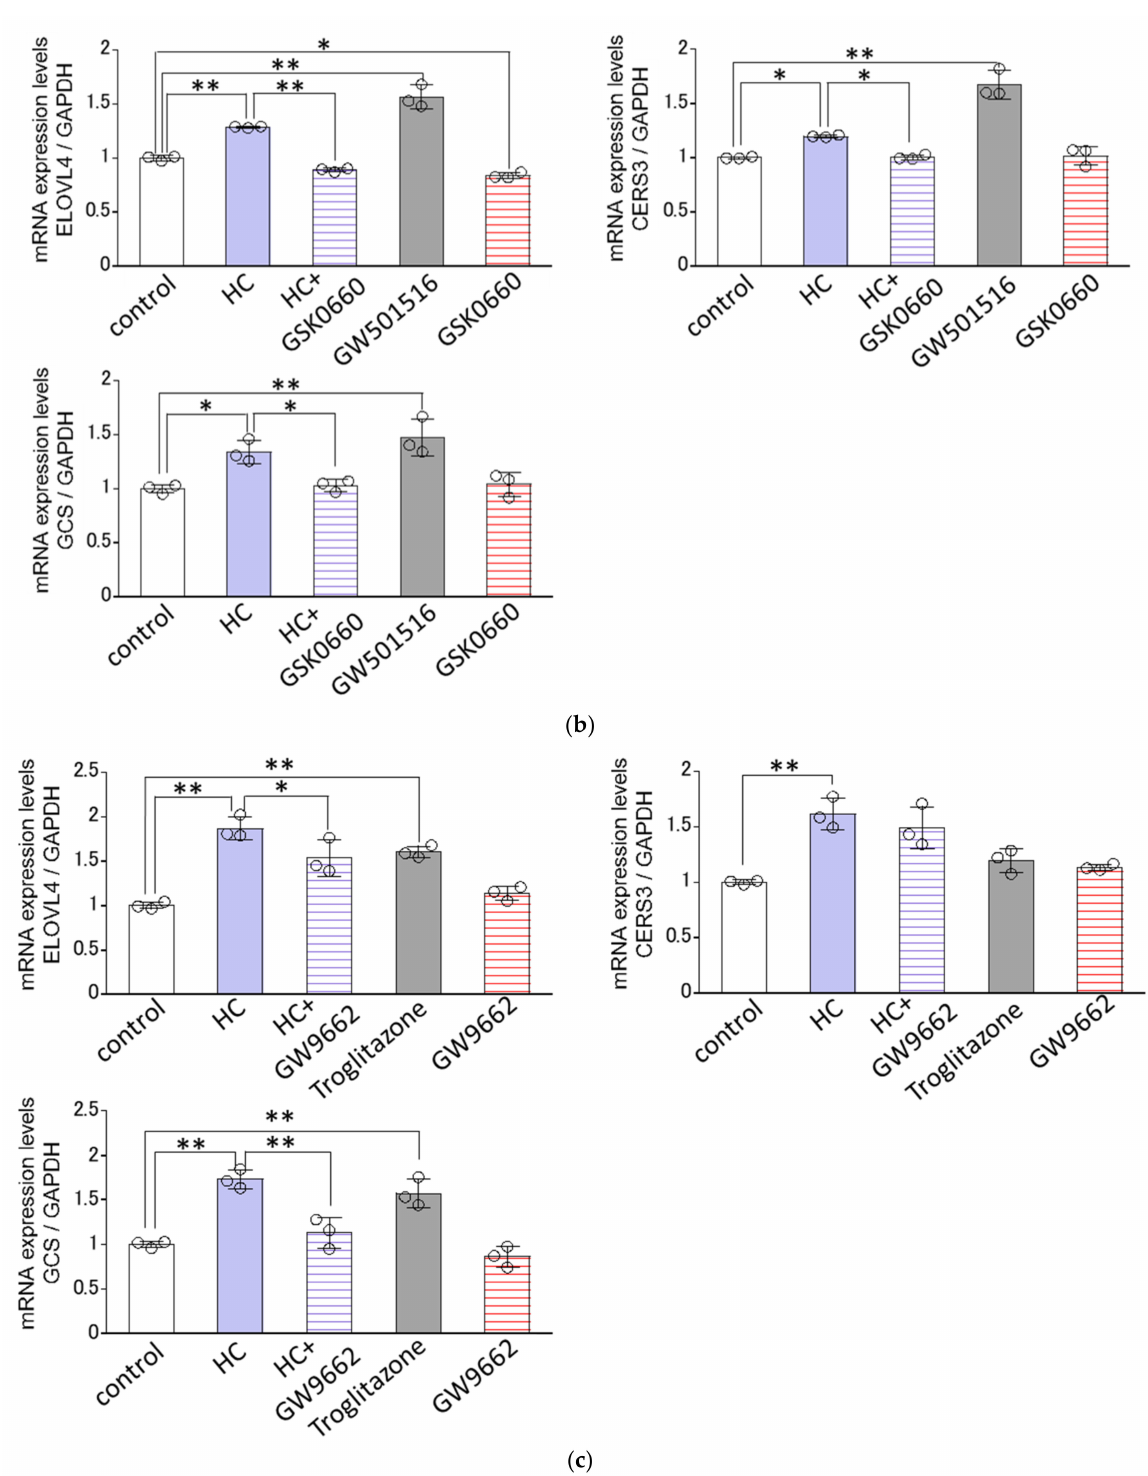
Figure 8. Effect of agonists or antagonists of PPARs on the HC-stimulated expression levels of ceramide synthesis-related genes under differentiating conditions of NHKs. Agonists/antagonists of ( a ) PPAR α , ( b ) PPAR β / δ , ( c ) PPAR γ . NHKs were treated with HC (at 0 or 200 µ g/mL), with or without an agonist or antagonist of PPARs for 48 h in differentiating conditions and total RNAs were extracted as described in the Section 4 Materials and Methods. mRNA expression levels were determined by real-time RT-PCR and are expressed as each mRNA level/GAPDH. Bars represent mean ± SD, n = 3, Tukey–Kramer multiple comparison test. *: p < 0.05, **: p <